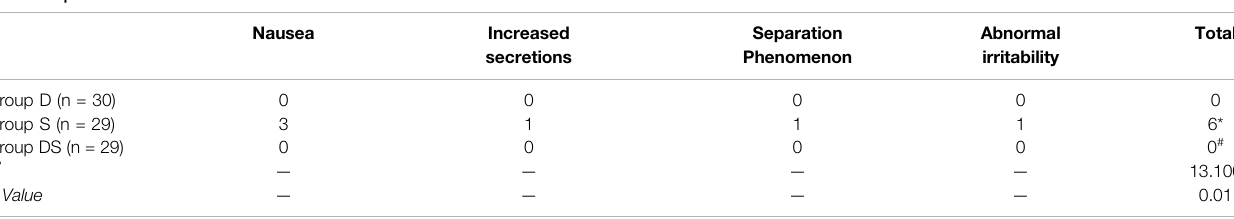
TABLE 7 | Adverse